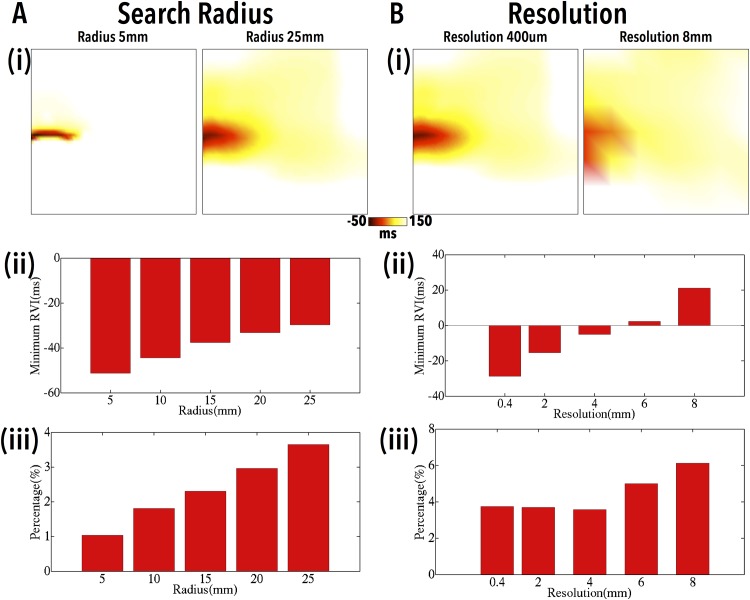
Variation in the RVI as search radius (A) and recording electrode resolution (B) is varied.Example spatial RVI maps (i) are shown for two selected radii (5, 25 mm) and resolutions (0.4, 8 mm), respectively, along with the variation in RV Imin (ii) and RV I%<50 (iii) as a function of search radius and electrode resolution, respectively.